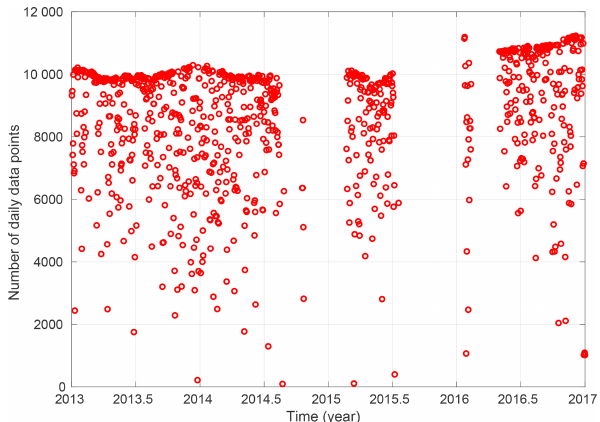
Figure 6. Number of data points per day observed by the WVR. During days without data loss, e.g. due to rain, each estimated gra- dient was based on ≈ 100 observations in the directions illustrated in Fig. 5. Observations close to the sun were removed from the raw data before the data analysis was carried out, which causes the sea- sonal variation in the maximum number of observations per day. During the last year the measurement cycle was optimized by re- ducing some of the time delays inserted between samples, but the observational sequence shown in Fig. 5 was used during the whole